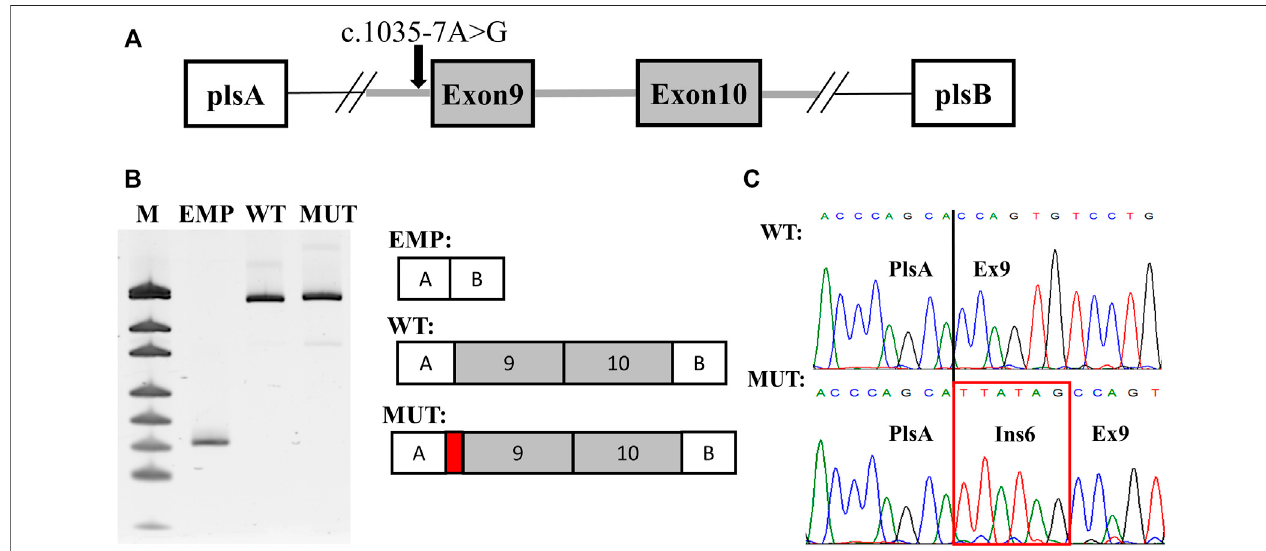
FIGURE 2 | Results of the splicing minigene assay. (A) scheme of the minigene plasmid. Red arrow indicates the c.1035 – 7A > G variant. (B) plasmid-speci fi c RT- PCR products in PAGE with urea. WT — wild-type isoform. MUT — mutated isoform. EMP — PCR product from an empty plasmid used as a control. M — pUC19 DNA molecular weight ladder. (C) Sanger sequencing of the detected isoforms. The 6-nucleotide extension of intron eight is highlighted by a red